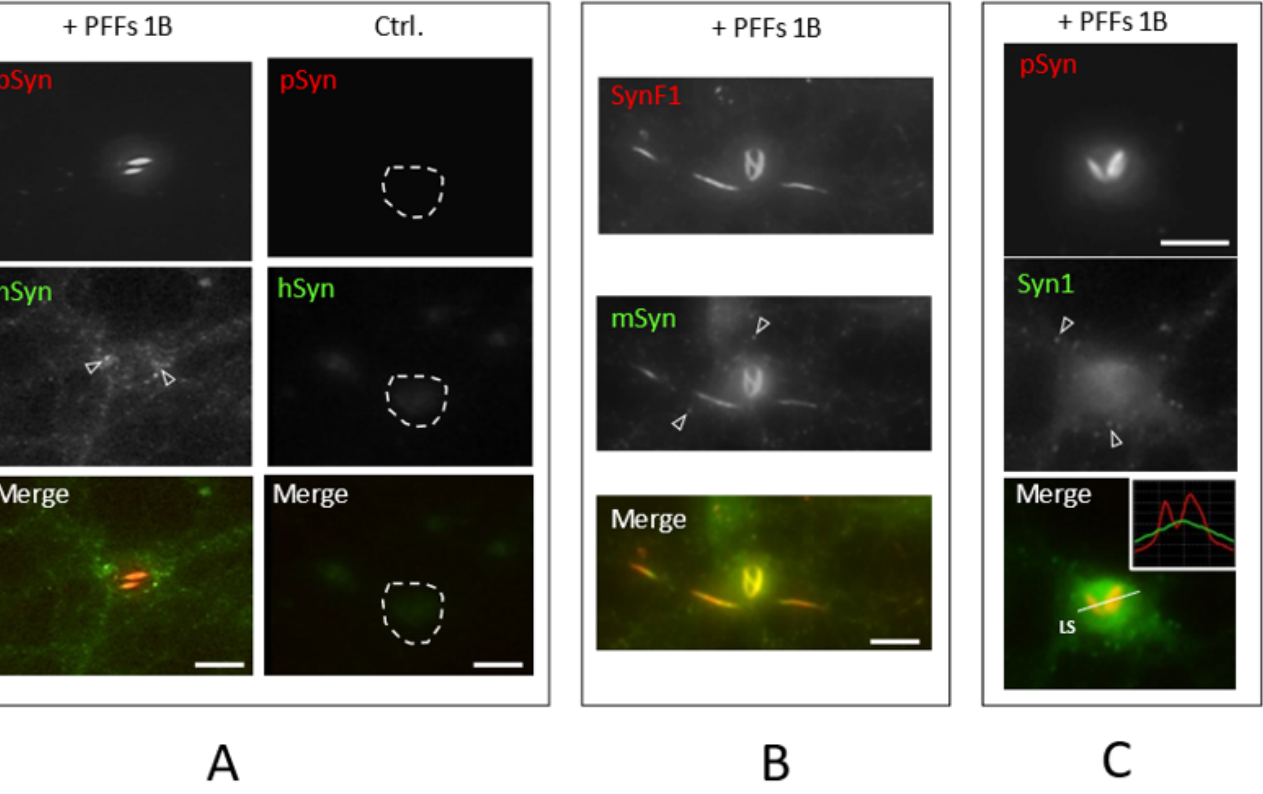
Figure 5. The 20 × HCA images of DIV30 mouse primary cortical neurons treated at DIV7 with 1B fibrils (+ PFFs 1B) or solvent only (Ctrl.). pSyn: phospho-S129 α -Syn; human and mouse α -Syn: hSyn and mSyn, respectively; SynF1 = fibrillar α -Syn; Syn1 = non-fibrillar α -Syn. For description of ( A – C ) see text. Scale bar: 10 μ m.